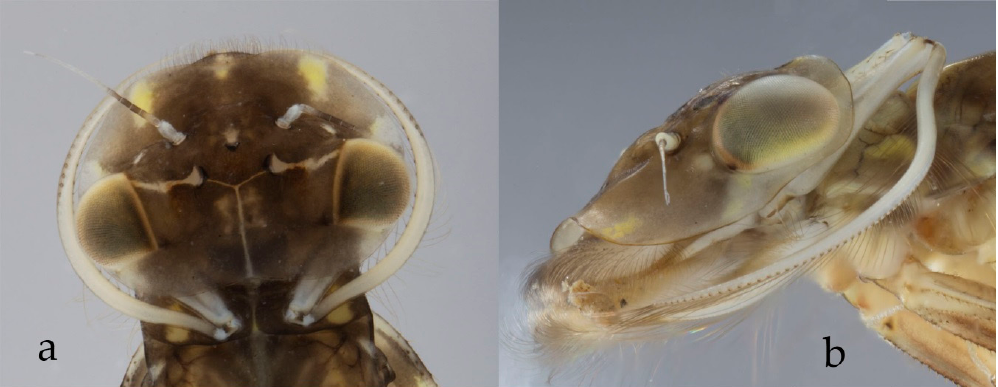
Figure 5. Oligoneuria mitra Salles, Soares, Massariol & Faria (Oligoneuriidae, Brazil) detail of head and prothorax in dorsal view; the first pair of legs equipped with filtering setae.